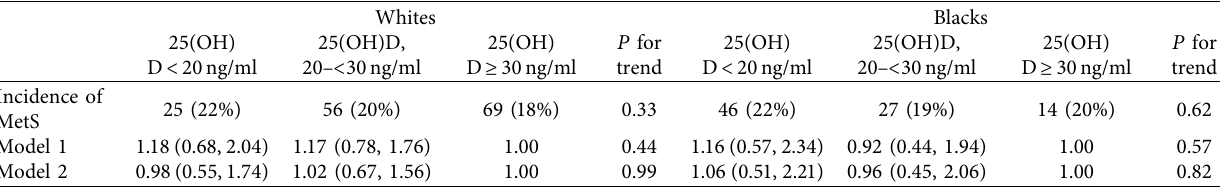
Table 4: Association between 25-hydroxyvitamin D levels and incident MetS at 6-year follow-up in the Health ABC cohort by race. Whites Blacks 25(OH) D < 20ng/ml trend Incidence of MetS Data represent number (percentage) and odds ratios (OR) with 95% confidence intervals (CI). Model 1, adjusted for age, gender, site, season, education, smoking status, alcohol use, physical activity, serum creatinine, and total energy intake. Model 2: adjusted for all variables in model 1 plus body mass index. 25(OH)D, 25-hydroxyvitamin